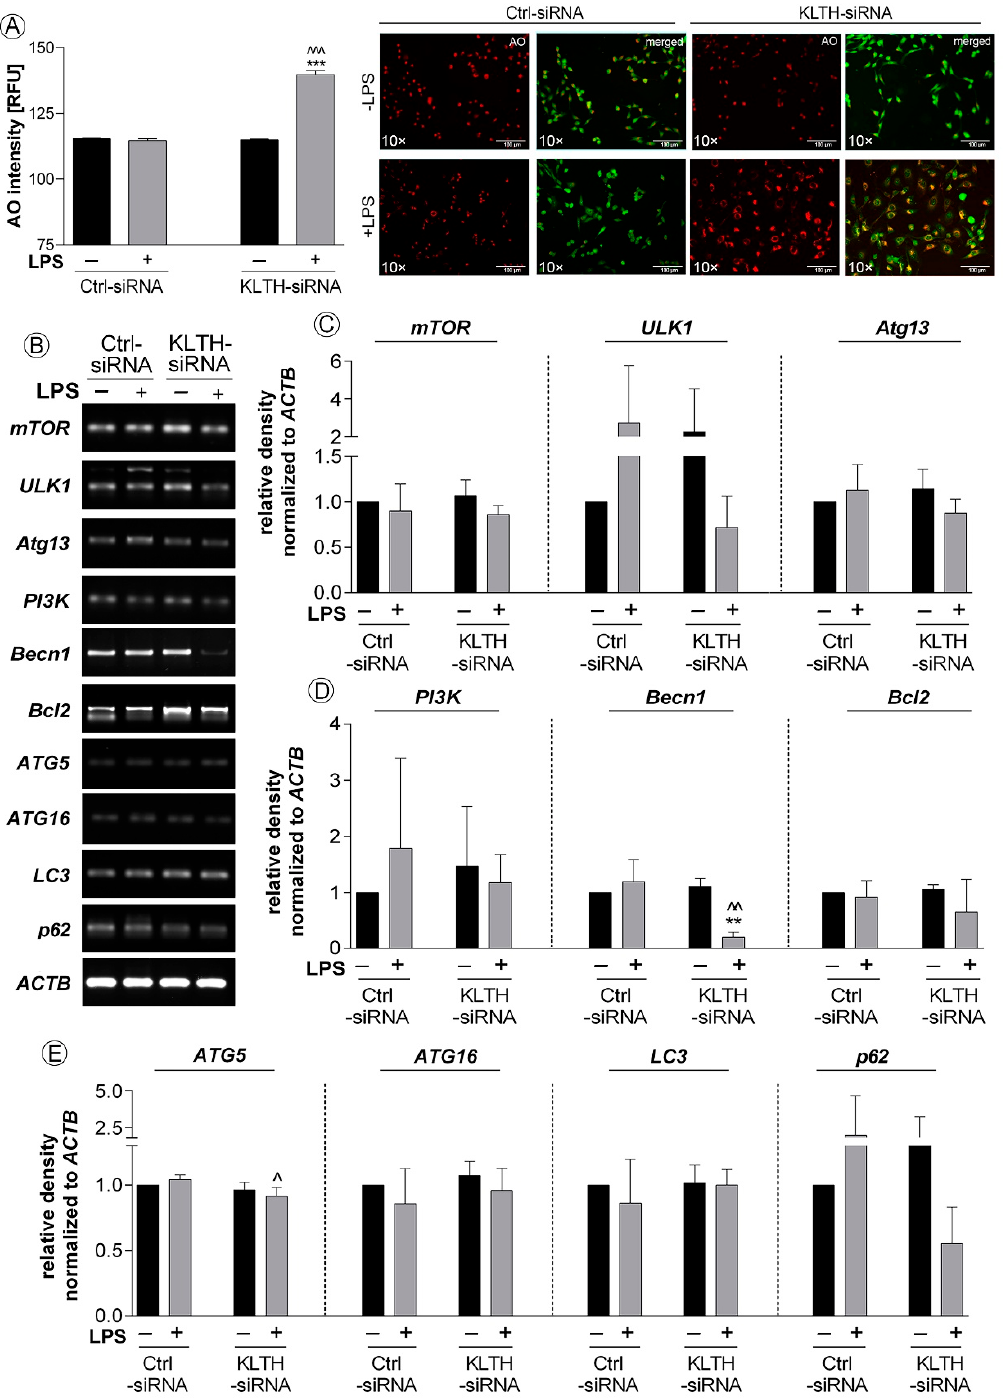
Figure 7. Klotho-silencing promotes activation of ER stress response but not autophagy. The cells were transfected, treated for 48 h with LPS and then: ( A ) presence of acidic compartments and ( B – E ) expression of genes involved in autophagy pathway were controlled. Magnification of the objective lens × 10; scale bar, 100 µ m. Bars indicate SD, n = 3, *** / ˆˆˆ p < 0.001, ** / ˆˆ p < 0.01, ˆ p < 0.05, no indication / no statistical significance (one-way ANOVA and Dunnett’s a posteriori test). (*) indicate comparison between LPS-non-treated and treated Ctrl-siRNA or KLTH-siRNA cells, (ˆ) indicate comparison between LPS-non treated Ctrl-siRNA and KLTH-siRNA cells or LPS-treated Ctrl-siRNA and KLTH-siRNA cells.